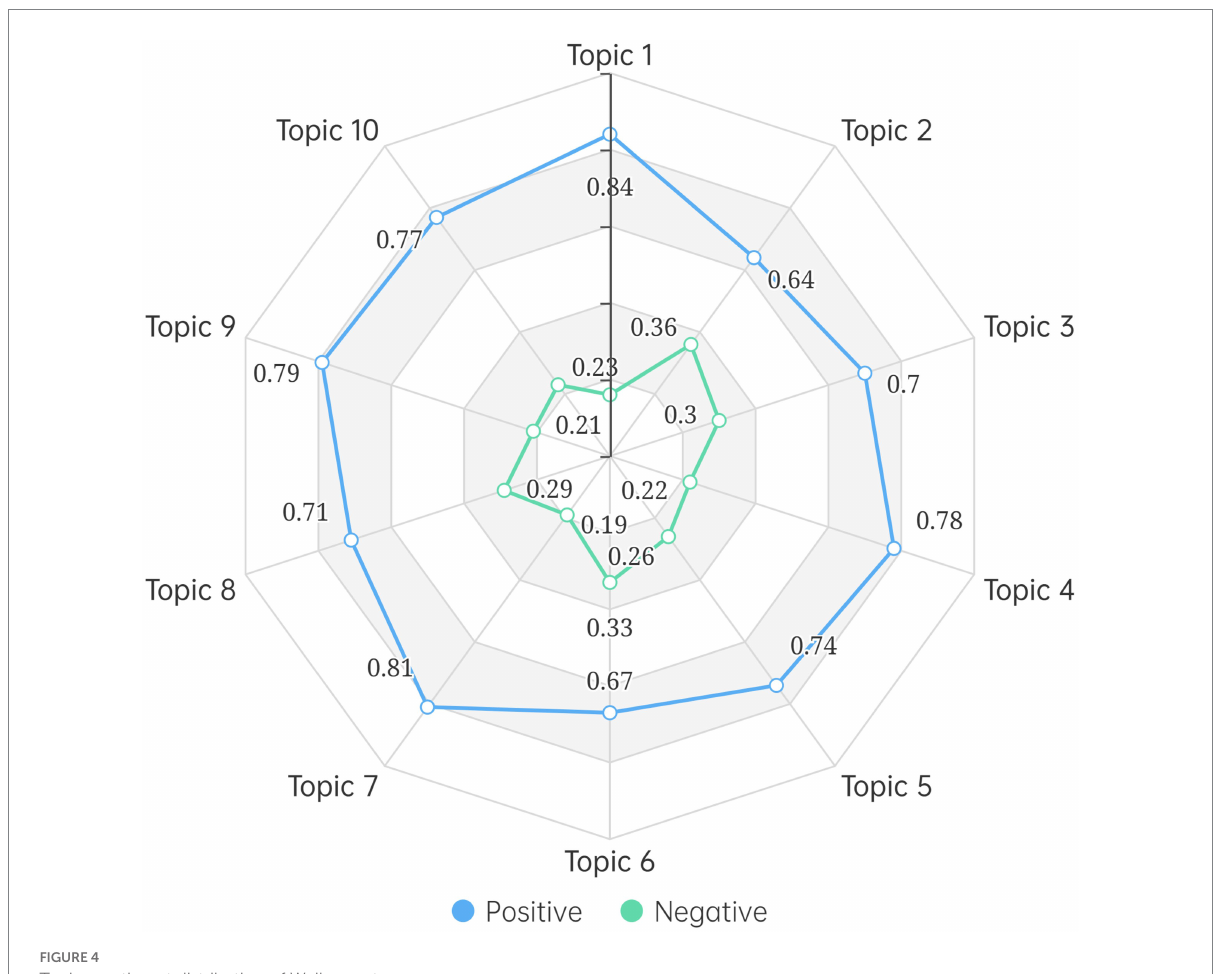
FIGURE 4 Topic–sentiment distribution of Weibo posts.